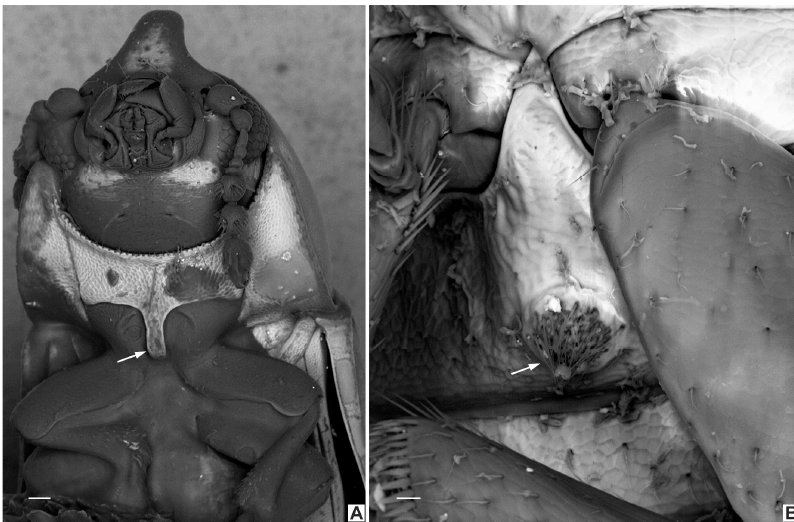
Figure 4. Ceracis cornifer (Mellié, 1849), SEM under variable pressure and without any sputter-coating of male specimen from Ubá (MG, Brazil). ( A ) prosternal process thin but not laminate (white arrow), ( B ) first abdominal ventrite with a sex patch (white arrow). Scale bars: A = 0.03 mm, B = 0.01 mm. Insects 2017 , 8 , 70